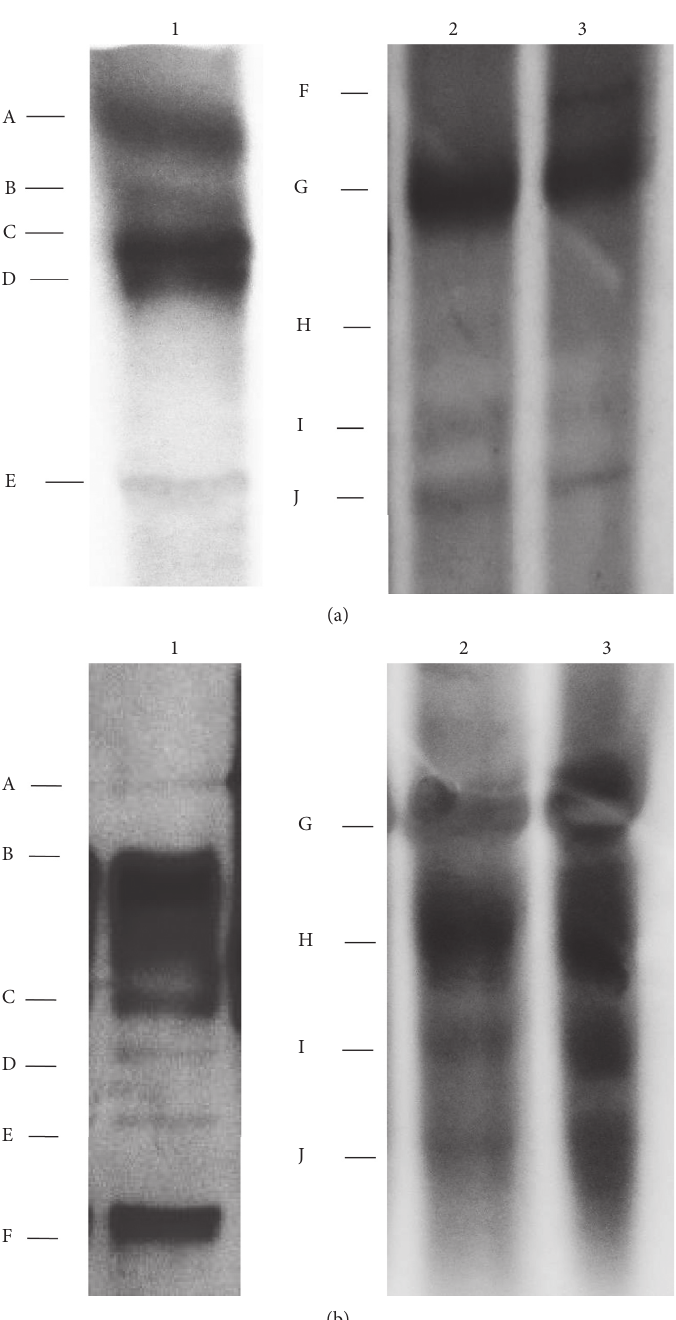
Figure 3: PCR-DGGE fingerprinting of the bacteria and yeast community in natural kefir grains and two different vectors: (a) bacteria community; (b) yeast community. 1 � natural kefir grains; 2 � cheese vector; 3 � encapsulated